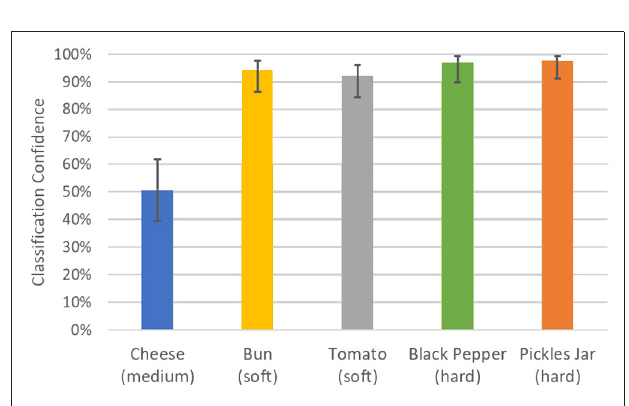
FIGURE 7 | Average classification confidence for the exoskeleton glove control enhancement experiment. The total number of matches over a period of 10 min was 375, with 25 players playing the game simultaneously. The average confidence interval for the object stiffness classification experiment was 82.1 % < p < 89.1 %